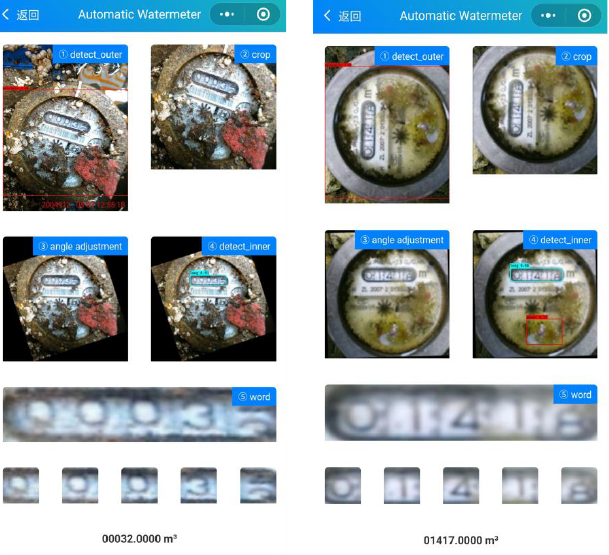
Figure 15. Failure cases. The pointer is partially obscured and cannot be recognized, and therefore cannot be